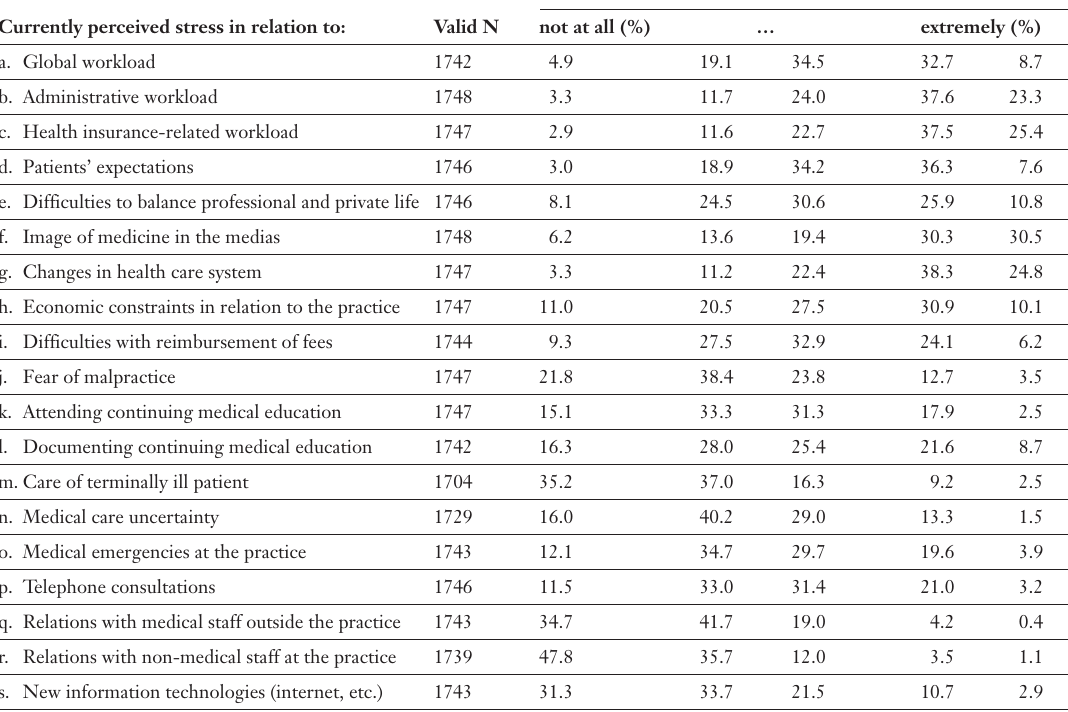
Table 2 Distribution of work-related stres- sors among 1755 Swiss primary care